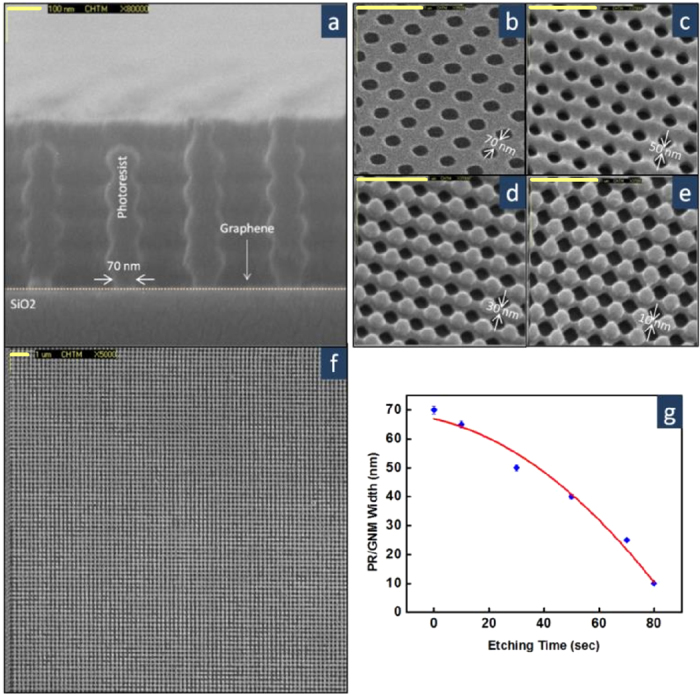
SEM images demonstrate the effect of etching on the PR/GNM line-width. (The scale bar for (a) is 100 nm; all the other scale bars are 1 μm).(a) Side view image of the PR hole array mask patterned on graphene film after the IL exposure, soft bake, and develop. The nominal PR width above the graphene film is ~70 nm. (b) Top view image of the PR hole array mask. (c) PR pattern after O2 plasma applied for 30 seconds. Due to the high pressure, the etching process was found to be dominantly lateral. The PR width is ~50 nm. (d) PR pattern after O2 plasma applied for 60 seconds, PR width ~30 nm. (e) Final step of etching when the PR width is reduced to ~10 nm after 80 seconds of etching. (f) Large-scale top-view image of the PR pattern after 80 seconds of etching. This pattern is continuously written across a 1 × 1 cm2 wafer. (g) PR/GNM width as a function of the etching duration (blue solid diamonds). The red line is a fit of the experimental data.